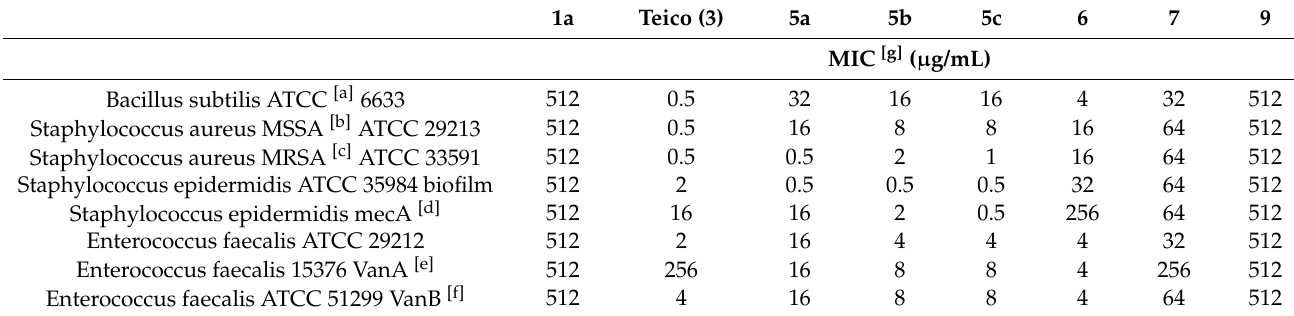
Table 3. Antibacterial